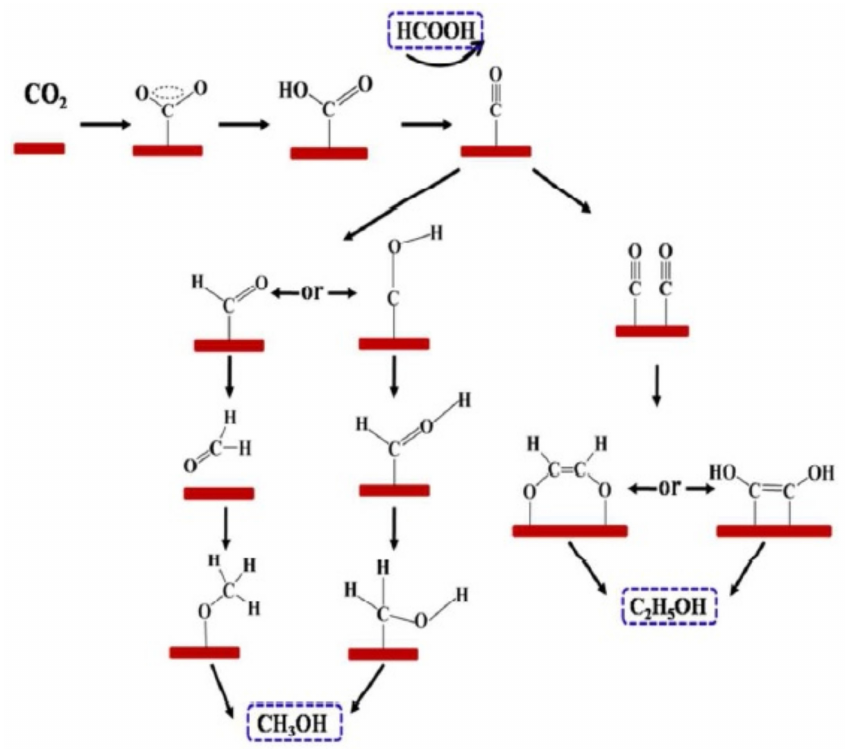
Figure 26. Proposed reaction pathways for electroconversion of CO 2 into alcohols on OD Cu/C- 1000